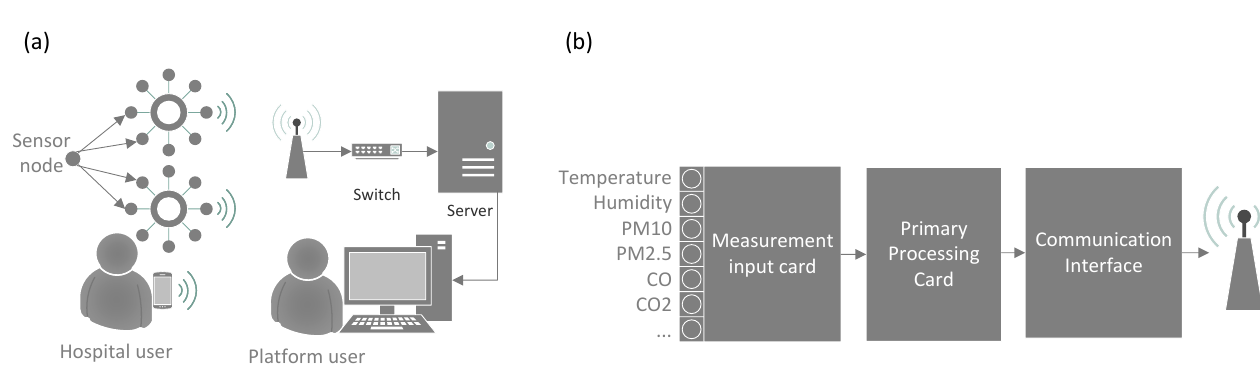
Figure 3. Schematics of IoT platform monitoring of thermal comfort and indoor air quality in hospitals: ( a ) Basic engineering of platform components; ( b ) basic engineering sensor